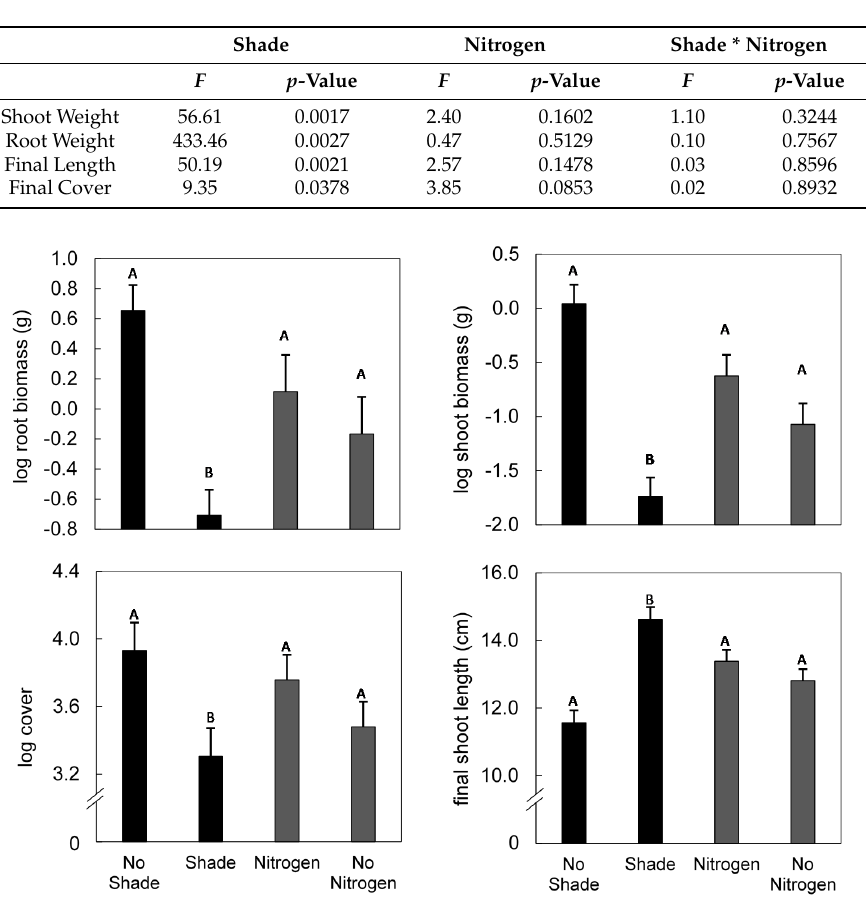
Figure 1. The effects of shade and nitrogen treatments on Idaho fescue shoot biomass, root biomass, shoot length, and cover. Columns represent group least squares means while error bars. Differing letters represent differences within treatment groups at the p < 0.05 level